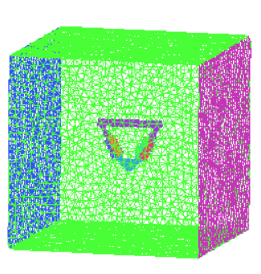
Figure 5. Meshing of the model.